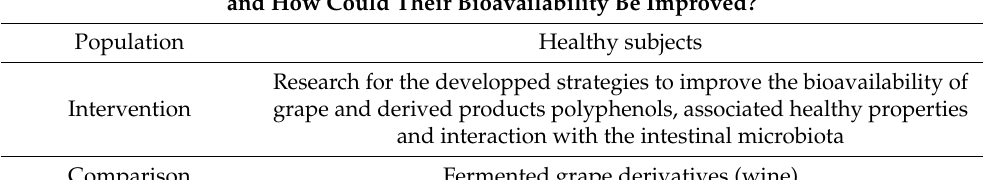
Table 1. PICO format on the research question of grape and grape by-products polyphenols. What Are the Health and Microbiota Effects of Grapes and Grape Derivatives Polyphenols,